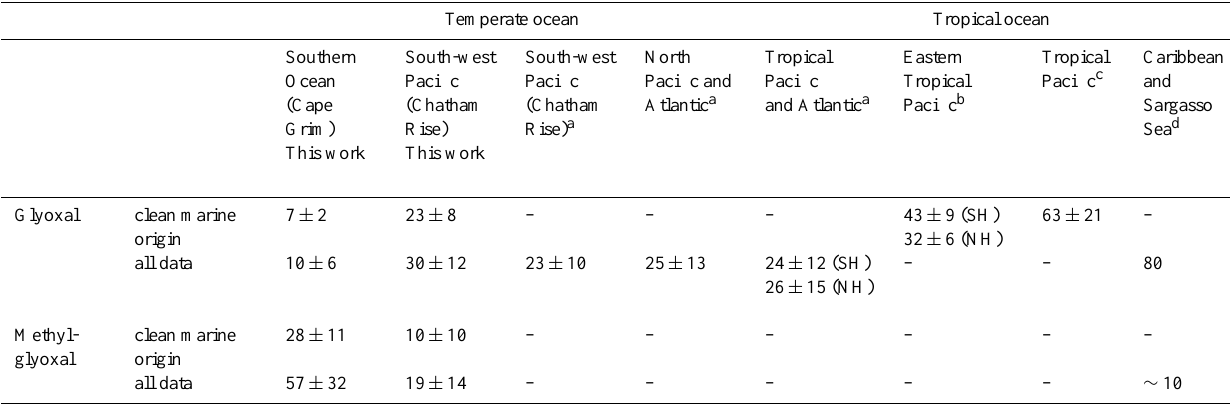
Table 2. Glyoxal and methylglyoxal compared to dicarbonyl measurements from other remote oceanic sites. Data is listed as being of clean marine origin where the study explicitly excludes terrestrial influence. All concentrations are in ppt. Values are mean ± SD; SH stands for Southern Hemisphere; NH stands for Northern